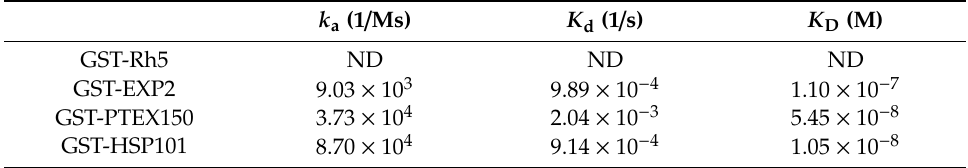
Table 2. Kinetic parameters for the interaction of PfPV1 with PTEX core